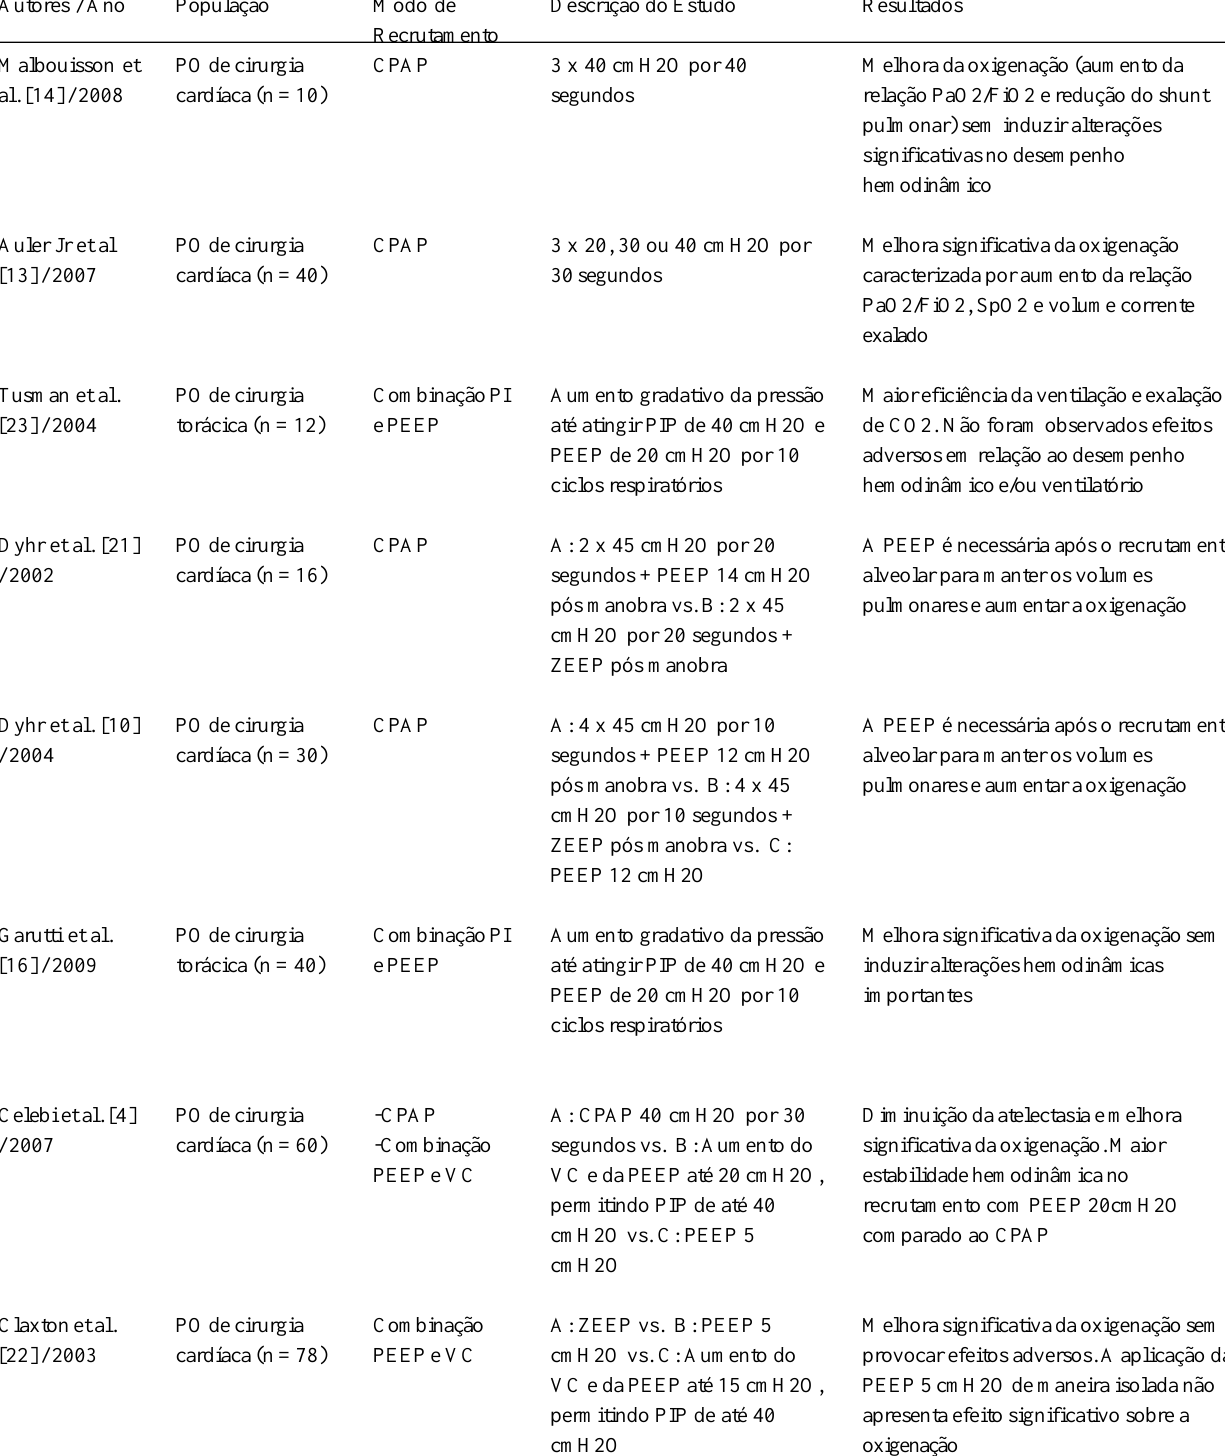
Tabela 1. Características dos Estudos